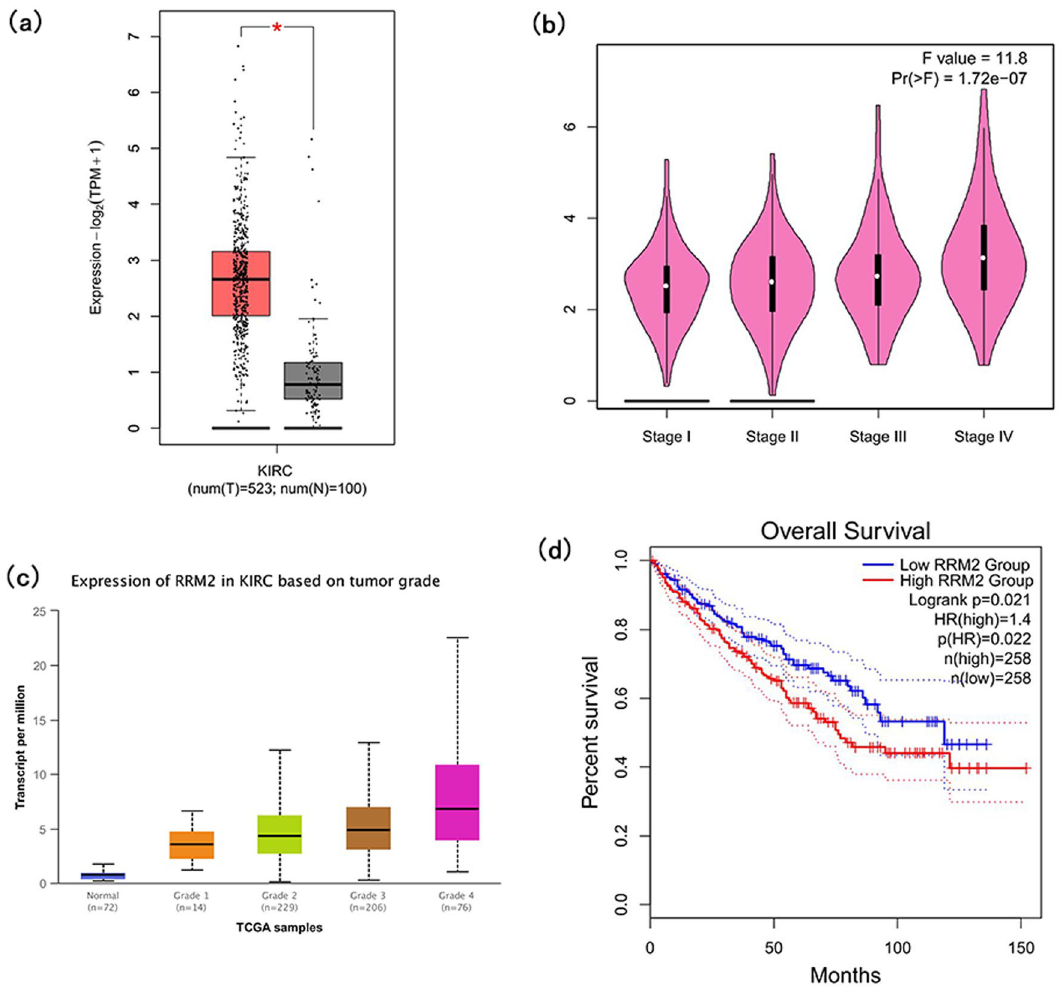
Figure 8. Confirmation of expression and prognosis of RRM2 from GEPIA2 and UALCAN databases. ( a ) RRM2 expression in tumor and ccRCC tissues (P < 0.05), the red indicated ccRCC tissues and the grey indicated normal tissues. ( b ) The expression of RRM2 increased with the advancement of the tumor stage (Pr = 1.72e−07). ( c ) RRM2 expression in KIRC according to tumor grade. ( d ) The high RRM2 was connected to the poor prognosis of individuals with ccRCC (P <